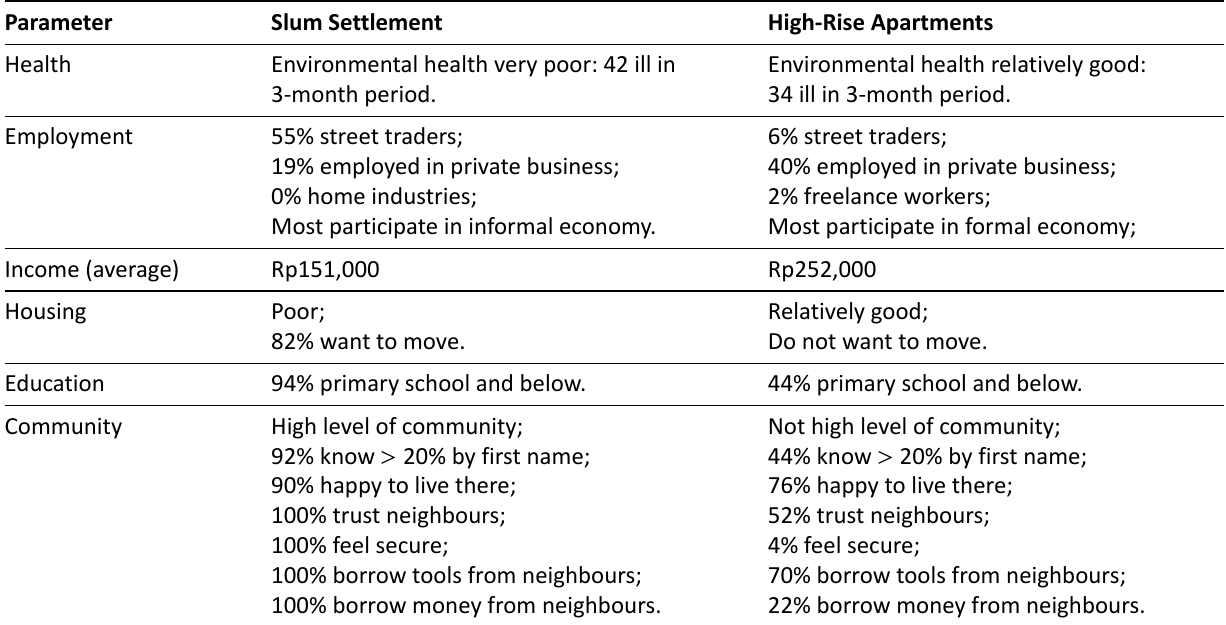
Table 3. Liveability of Ciliwung River slum settlement and high-rise apartments, Jakarta, Indonesia. Source: Arief (1998).